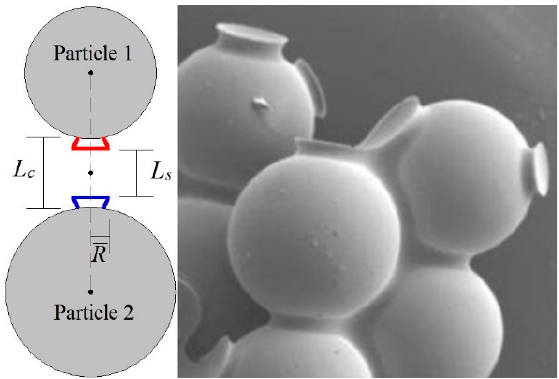
Figure 3. Schematic diagram of the parallel bond. The bond broken satisfies Equation (8), which is applicable when the force on the parallel bond exceeds the tensile strength limit.